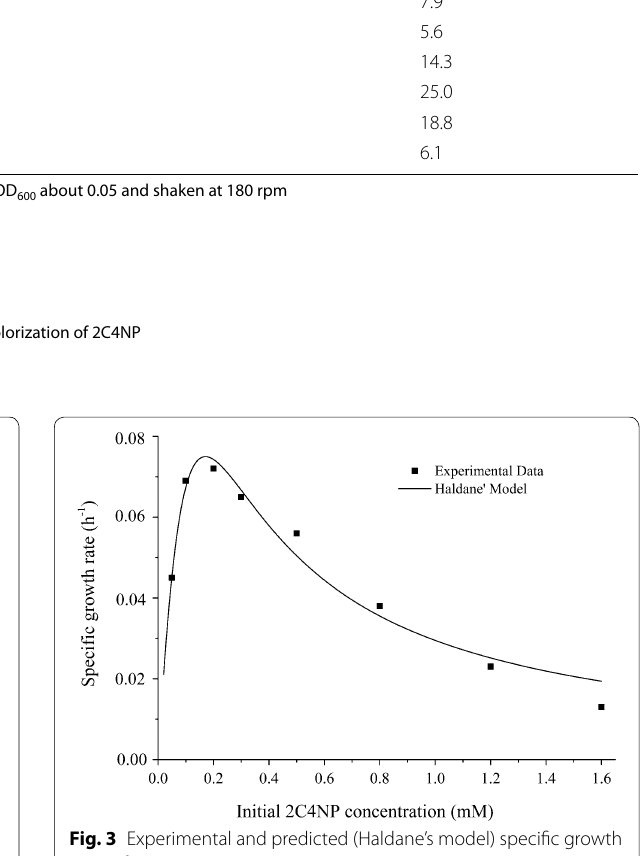
standard deviation (n 3) ± =